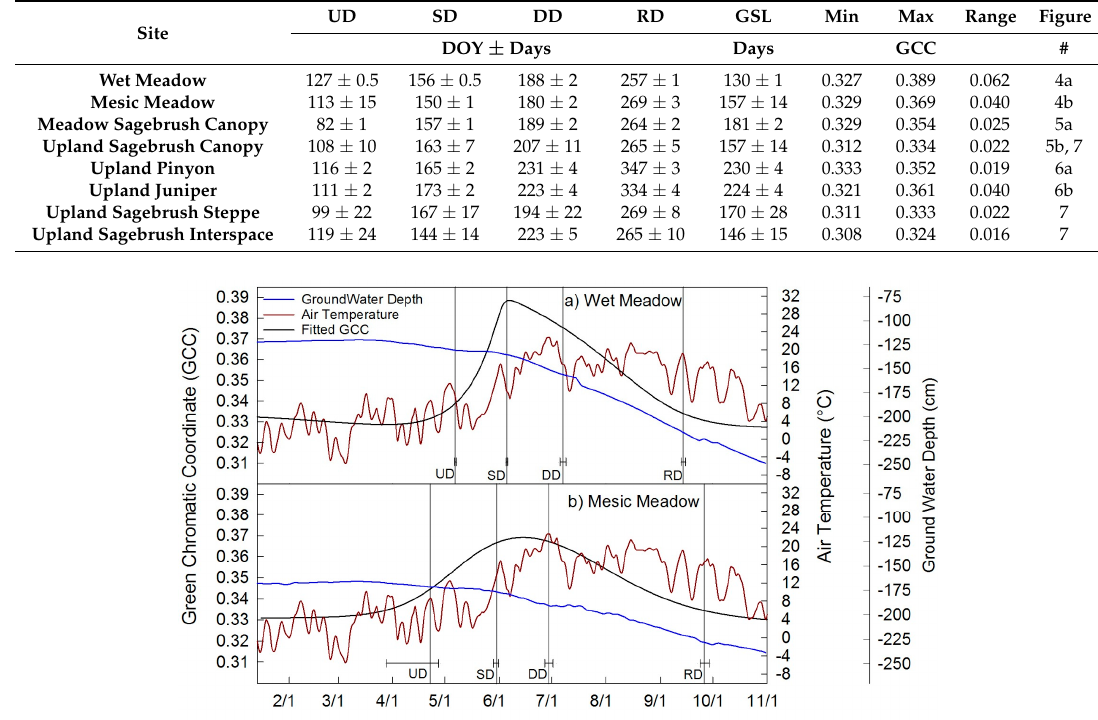
Table 2. A summary of phenophase dates from averaged regions of interest (ROI Sites): upturn date (UD), stabilization date (SD), downturn date (DD), recession date (RD), growing season length (GSL), annual minimum GCC, maximum GCC, and total range of green chromatic coordinates (GCC) with the associated figure number.